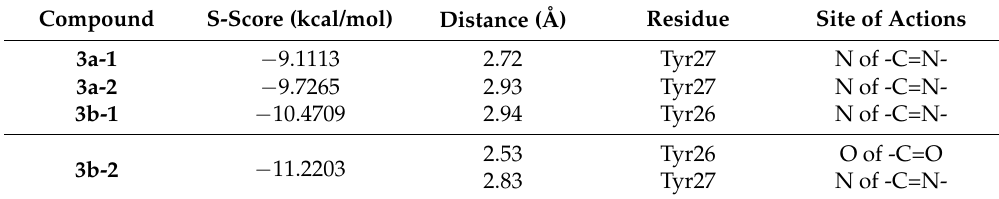
Table 1. Docking results of synthesized compounds with